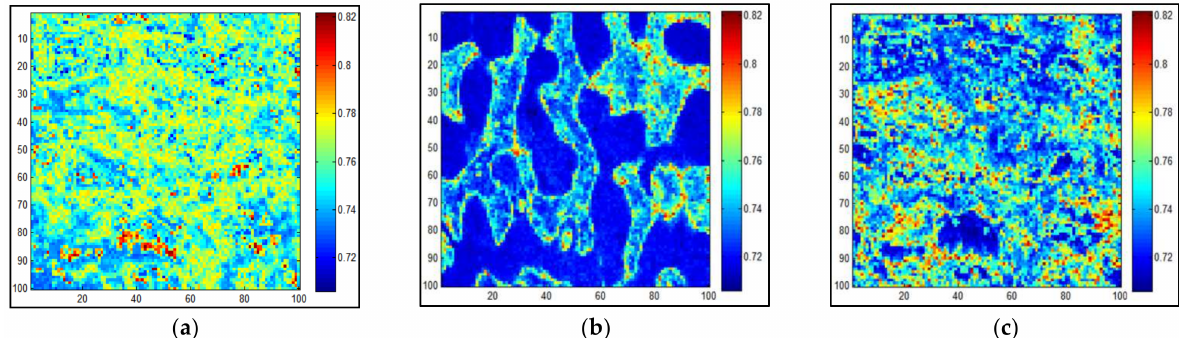
Figure 15. 100 × 100 grid multi-scale pore structure image search diagram. ( a ) Macro mesoscopic search; ( b ) Mesoscopic micro search; ( c ) Macro micro